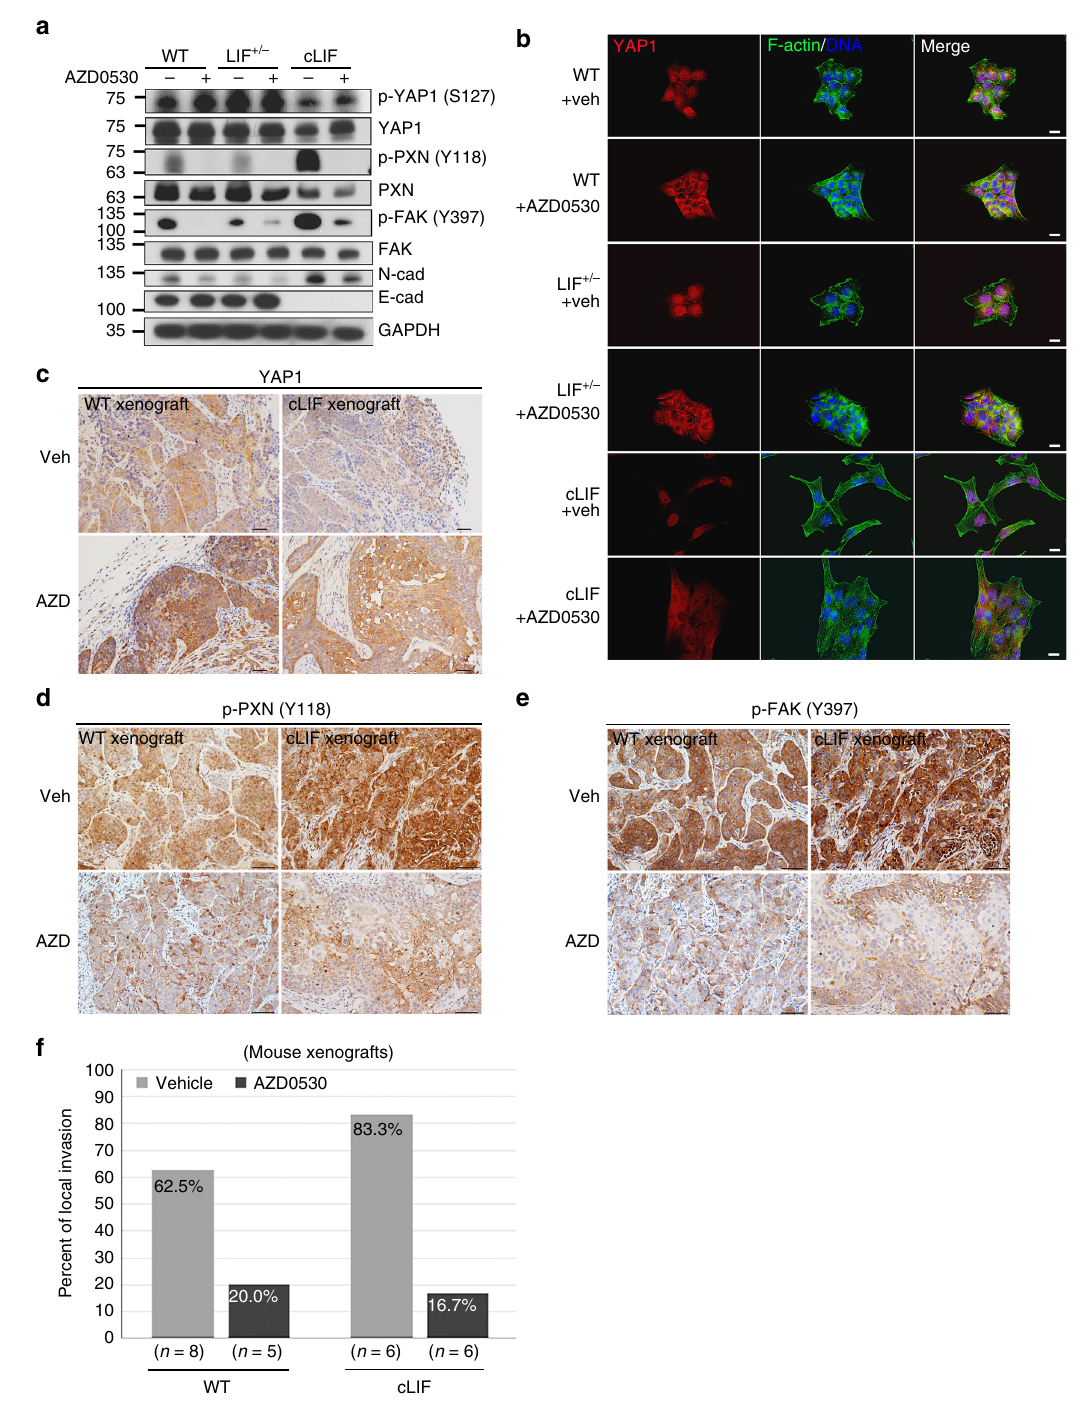
Fig. 7 AZD0530 treatment suppresses LIF-mediated tumor invasion. a Western blot analysis of YAP1 and focal adhesion proteins in cancer cells treated with AZD0530 (5 μ M). Protein lysates were harvested at 24 h post treatment. b Immunostaining for YAP1 (red) in cancer cells treated with AZD0530. Alexa Fluor 488 phalloidin (green) was used to stain F-actin. Blue, nuclear staining. Scale bars, 10 μ m. c – e Representative images of YAP1 ( c ), p-PXN (Y118) ( d ), and p-FAK (Y397) ( e ) expression in mouse WT and cLIF xenografts treated with AZD0530 or vehicle. Scale bars, 50 μ m. f Quanti fi cation of mouse NPC xenografts with events of local invasion based on results of hematoxylin and eosin staining. The AZD0530 treatment procedure in the mouse model is described in